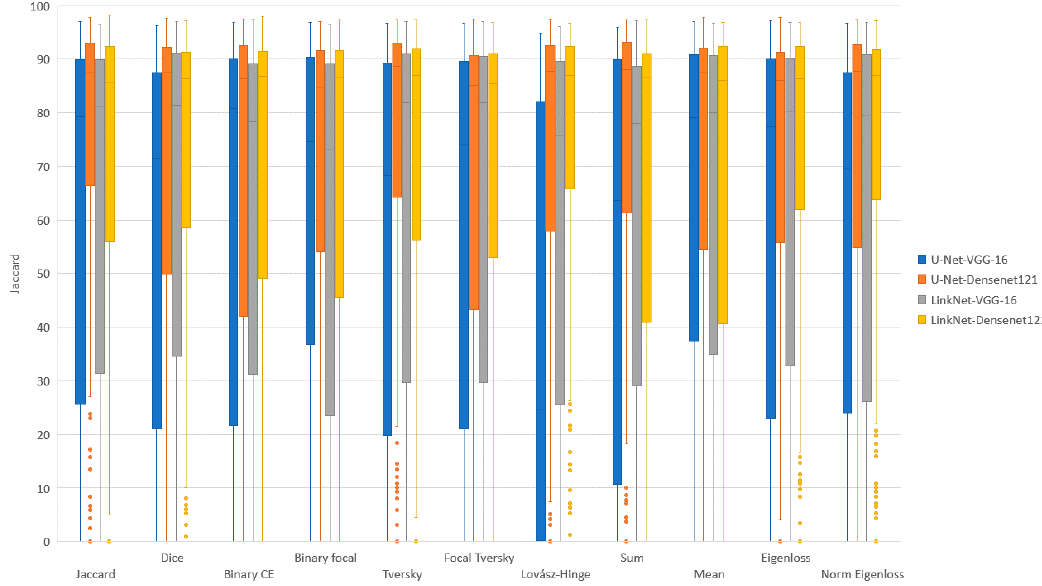
Figure 4. Boxplot for the Jaccard index for the different models and loss functions analyzed.